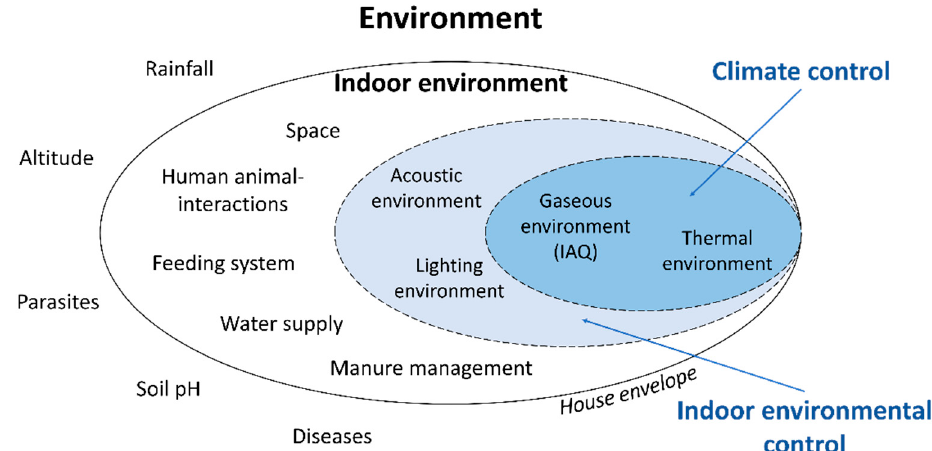
Figure 1. Elements of livestock production that are affected by indoor environmental control and climate control, respectively, among all the livestock production elements. The figure shows only part of the elements of the environment as an example.